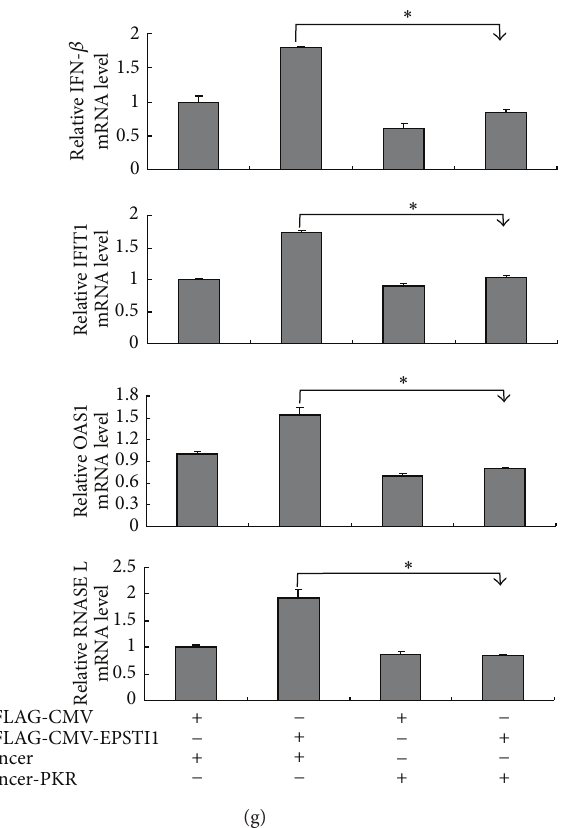
Figure 6: The inhibition of HCV triggered by EPSTI1 is dependent on PKR. ((a) and (b)) Huh7.5 cells (a) and HLCZ01 cells (b) were infected with HCV (MOI = 0.1). EPSTI1 mRNA was detected with real-time PCR and normalized with GAPDH. ((c), (d), and (e)) Huh7.5 and HLCZ01 cellsweretransfectedwithp3XFLAG-CMV-EPSTI1orpSilencer-EPSTI1followedbyHCVinfection.IntracellularHCVRNAandPKRmRNA were detected by real-time PCR and normalized with GAPDH. The proteins of PKR and p-PKR were detected by western blot. ((f) and (g)) p3XFLAG-CMV-EPSTI1 or/and pSilencer-PKR was delivered into HLCZ01 cells followed by HCV infection. (f) HCV RNA and PKR mRNA were detected by real-time PCR and normalized with GAPDH. NS5A and PKR proteins were detected by western blot. (g) IFN- 𝛽 , IFIT1, OAS1, and RNASE L mRNA were detected by real-time PCR and normalized with